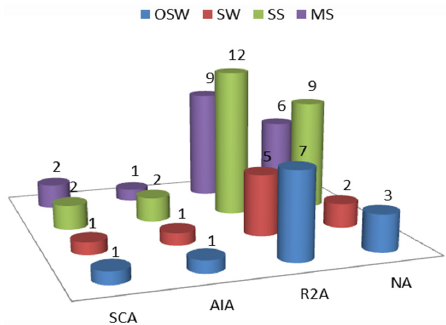
Figure 3. The number of isolates recovered by each medium—NA: nutrient agar, R2A: Reasoner’s 2A agar. AIA; Actinomycete isolation agar, and SCA; starch casein agar. OSW: off-shore water, SW: shore water, SS: sandy sediment, and MS: muddy sediment.